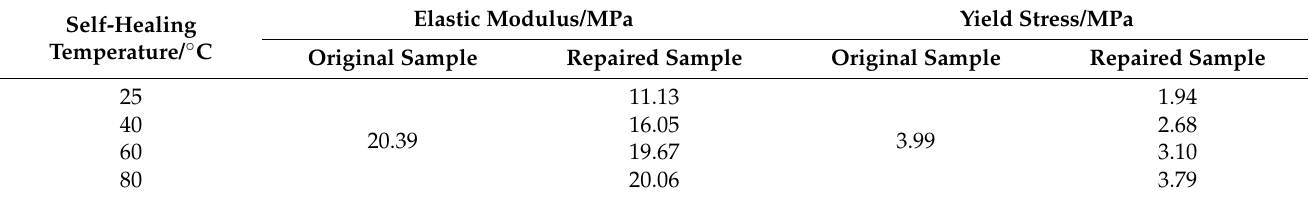
Table 4. Elastic modulus and yield stress of PUSS-6 after self-repair at different temperatures. Elastic Modulus/MPa Yield Stress/MPa Self-Healing Temperature/ ◦ C Original